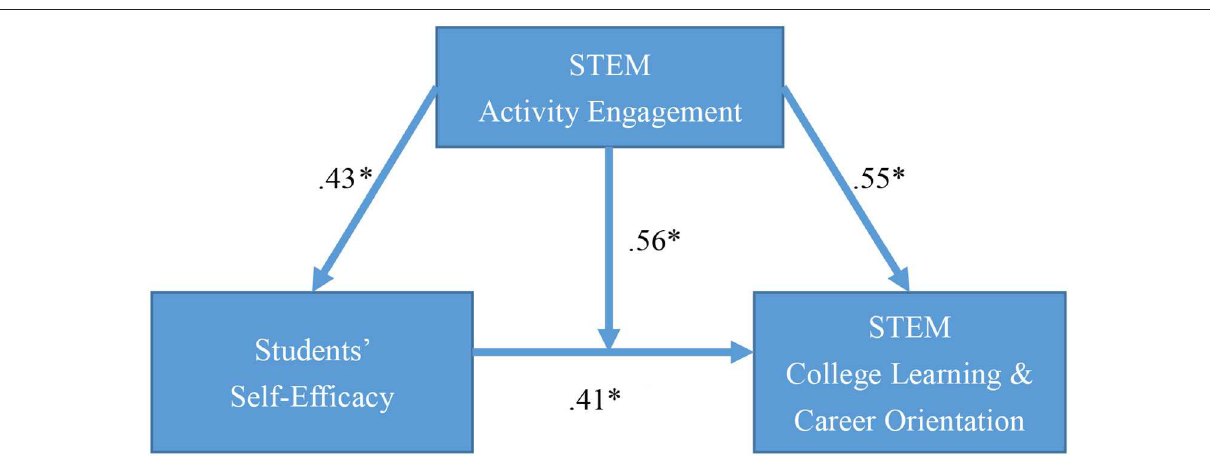
FIGURE 4 | The relationships between STEM activity engagement, students’ self-efficacy, and STEM college learning and career orientation by using a moderator analysis. * p <